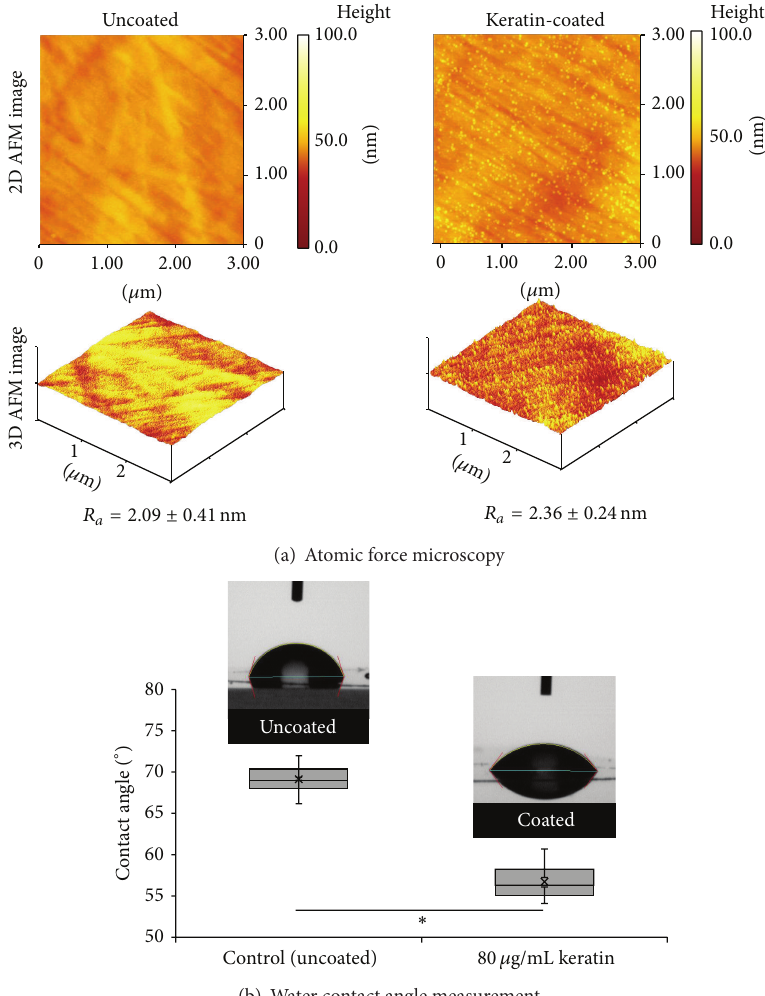
Figure 2: Surface characteristic of uncoated and keratin-coated TCPS. (a) 2D and 3D AFM images showing topography of surfaces and mean roughness ( 𝑅 𝑎 ). (b) Water contact angle measurement showing increased hydrophilicity upon keratin coating; ∗ 𝑃 < 0.05